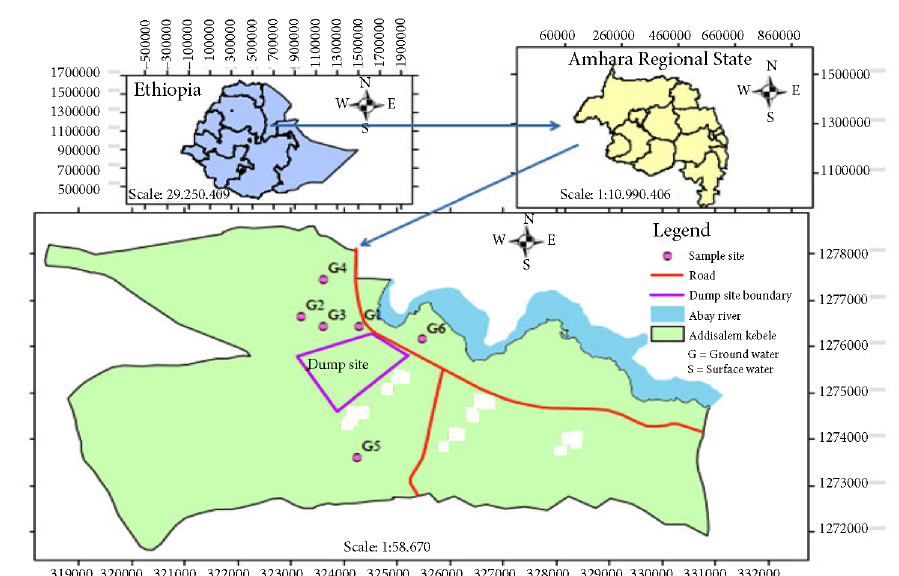
Figure 1. Topographic map of the study